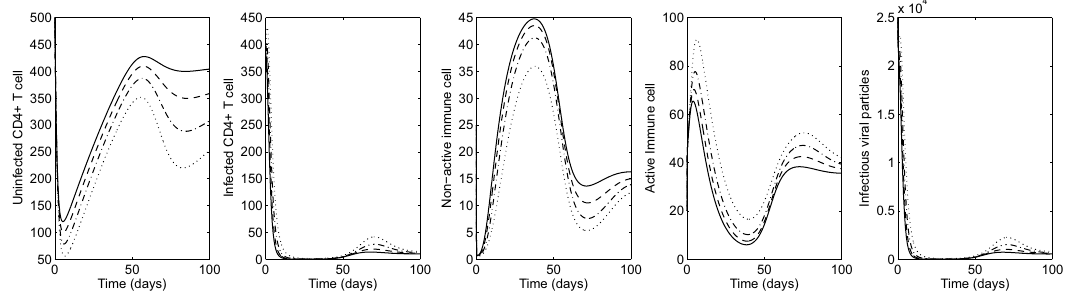
Figure 5. Advanced-stage HIV dynamics in the absence of controls under four different values of γ ( β = 0.000025 is fixed): γ = 0.002 (dotted), γ = 0.004 (dash-dot); γ = 0.006 (dashed) and γ = 0.008